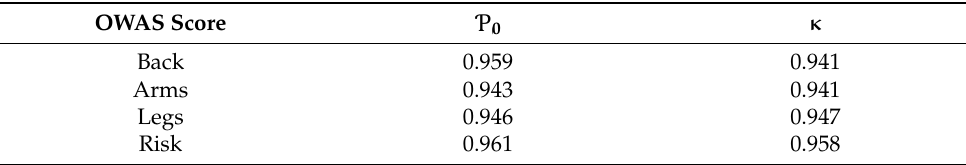
Table 9. OWAS score accuracy compared with expert scores with observed agreement (